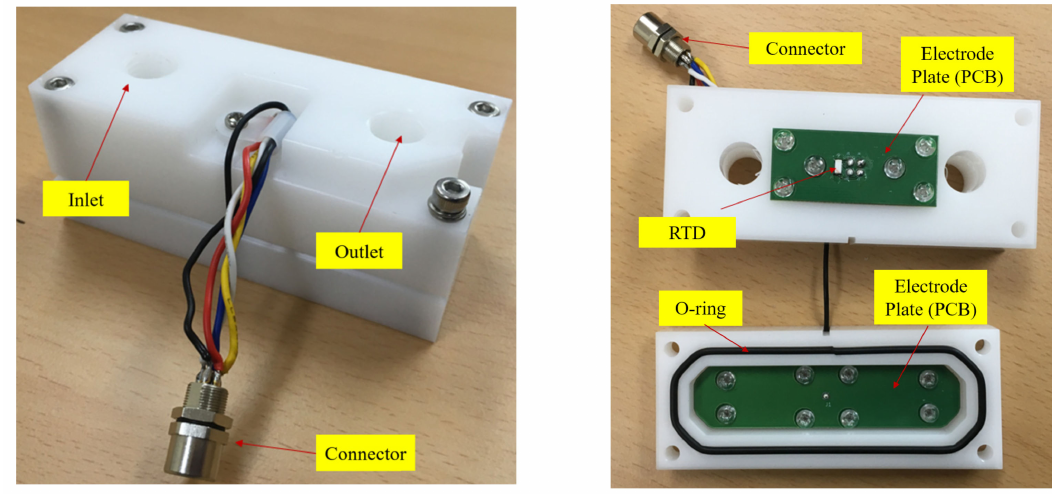
Figure 12. Design of impedance sensor with